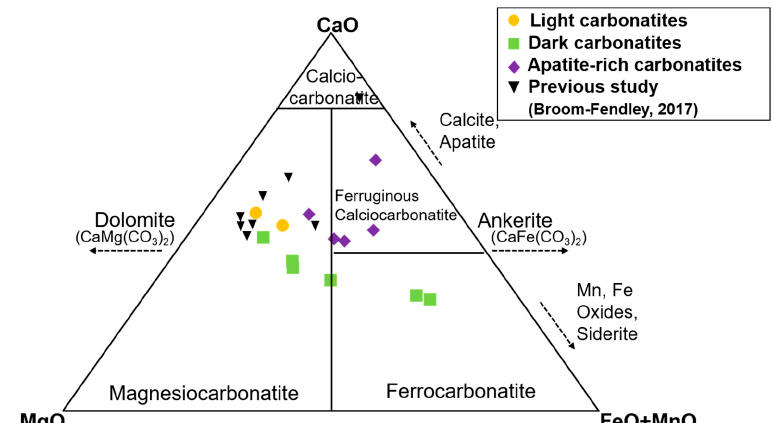
Figure 4. Classification of the Kangankunde carbonatites using molar proportions of CaO, MgO, and FeO + MnO (after Grittins and Harmer [35]). Arrows indicate the trends that occur with increasing contents of the specified minerals. Chemical compositoins of the Kangankunde carbonatites from a previous study [5] are plotted for comparison.